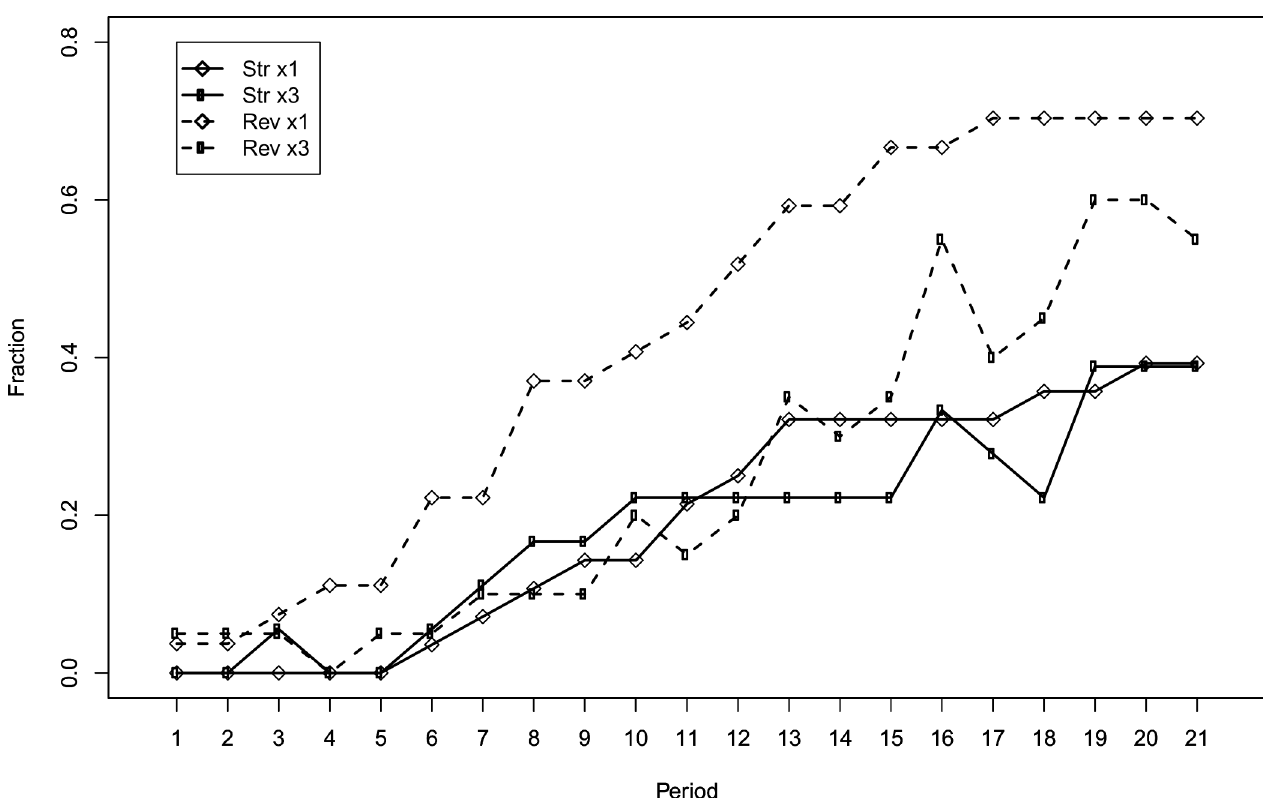
Fig 4. Fraction of efficient choices by round and